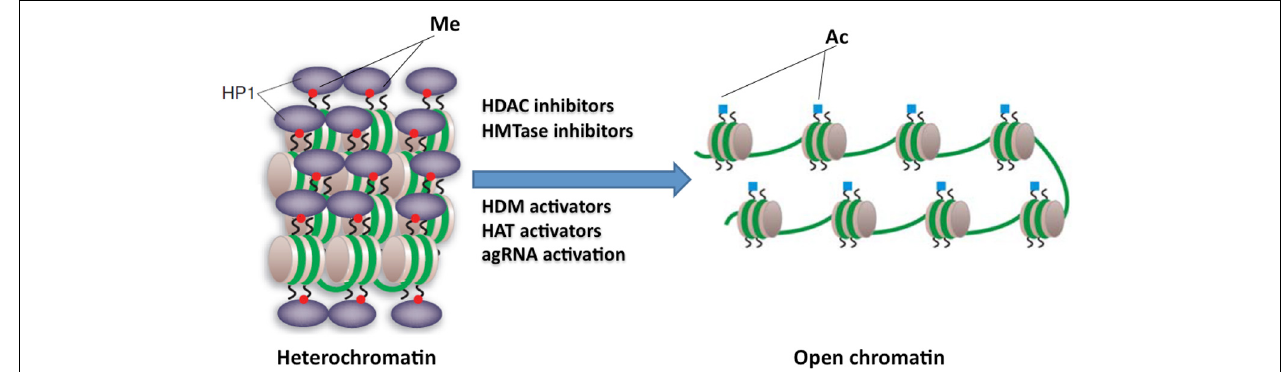
FIGURE 3 | Potential epigenetic-based therapies for FRDA. Large GAA • TTC repeats in FRDA patients are associated with heterochromatin mediated FXN gene silencing. The use of specific HDAC inhibitors, HDM activators, HAT activators, HMTase inhibitors,